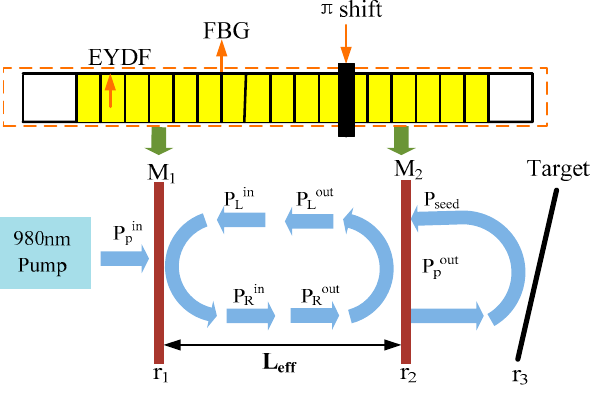
Figure 1. The theoretical model of all-fiber configuration self-mixing interference laser Doppler velocimeter (SM-LDV) system based on the π -phase shifted DFB fiber laser. EYDF: Er 3+ -Yb 3+ co-doped optical fiber; FBG: fiber Bragg grating.